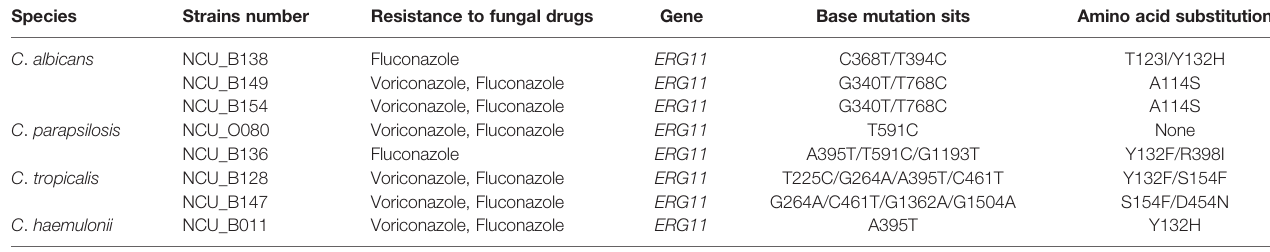
TABLE 5 | Polymorphic sites in ERG11 sequences.